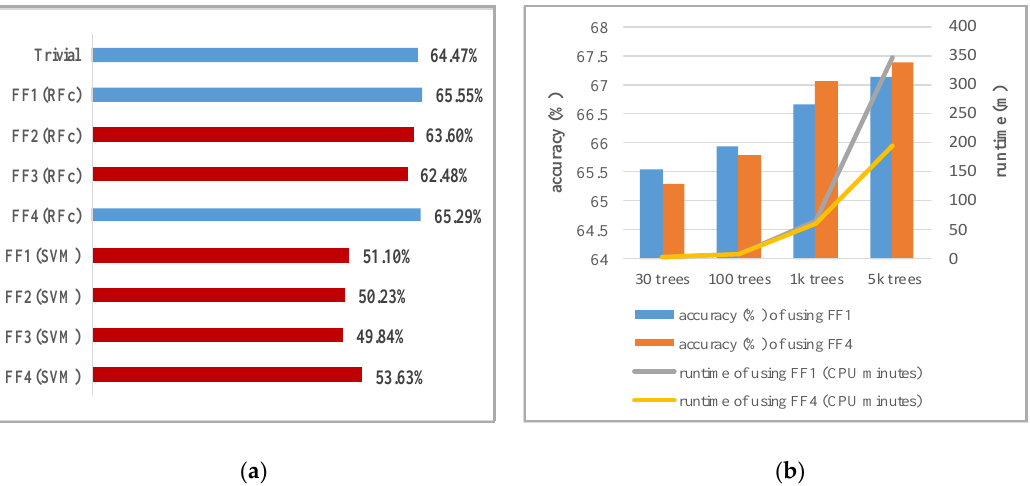
Figure 2. The accuracy of RFc and SVM: ( a ) The accuracy of RFc (30 trees), SVM, and informed guess (trivial) using leave-one-session-out crossvalidation; ( b ) The accuracy and runtime of RFc using FF1 and FF4 with varying number of trees.